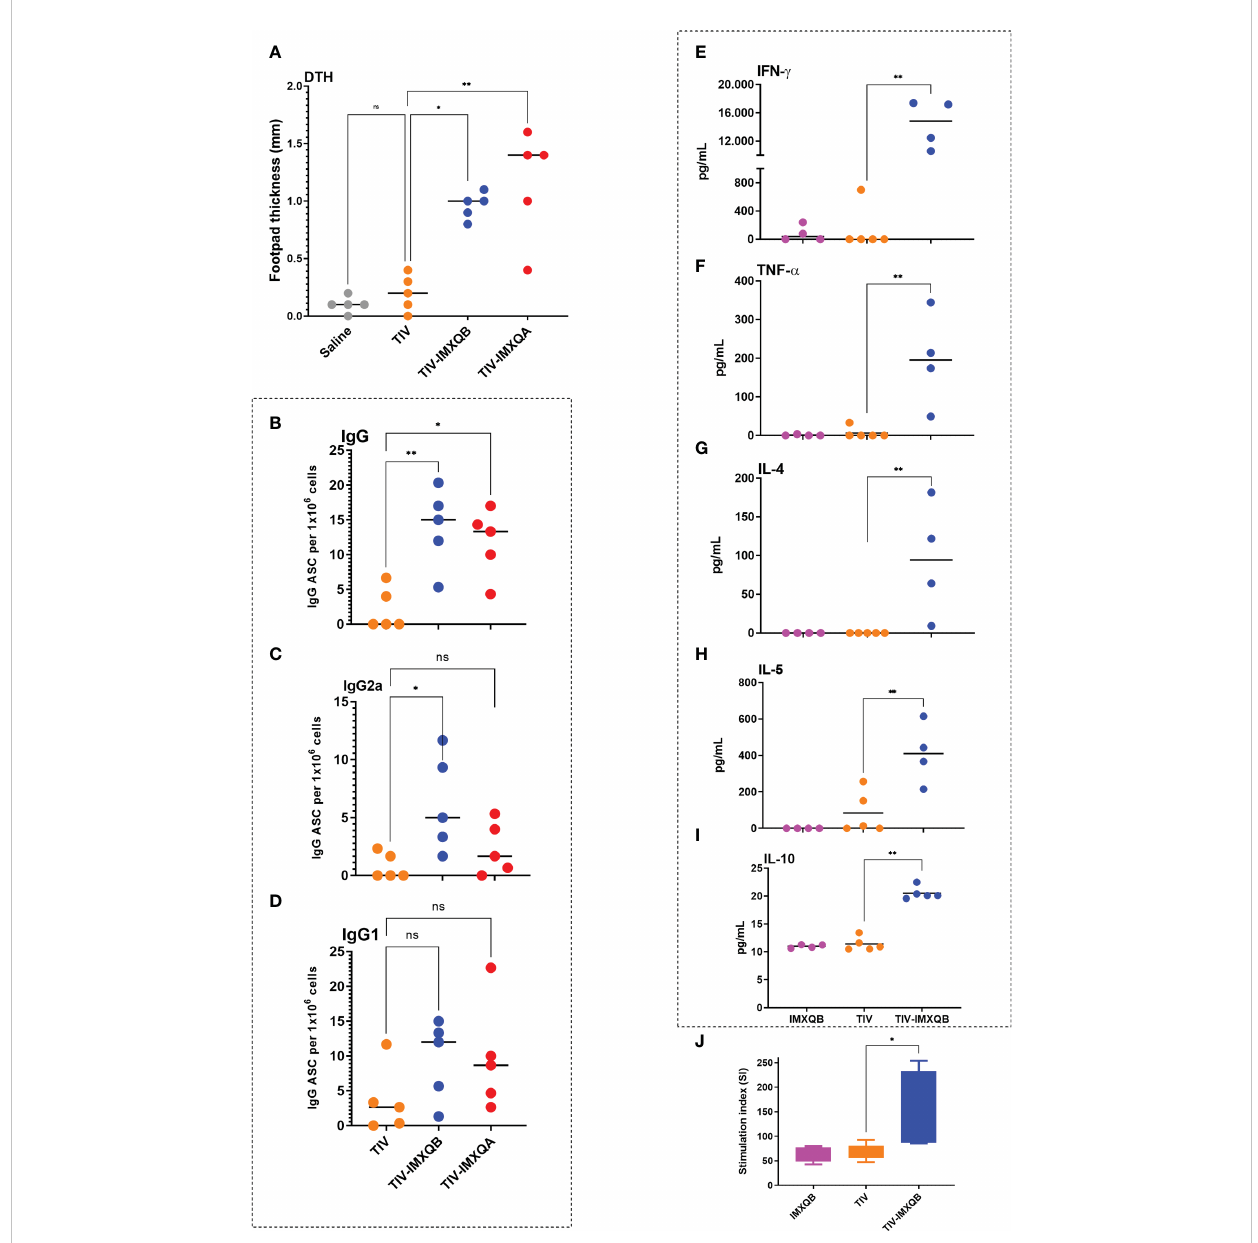
FIGURE 4 TIV-IMXQB promotes T helper cell type 1 (Th1)/T helper cell type 2 (Th2) mixed immune responses. Female BALB/c mice ( n = 5) were inoculated subcutaneously on days 0 (priming) and 14 (booster) with saline, trivalent in fl uenza vaccine (TIV) alone, TIV-IMXQB, or TIV-IMXQA. The